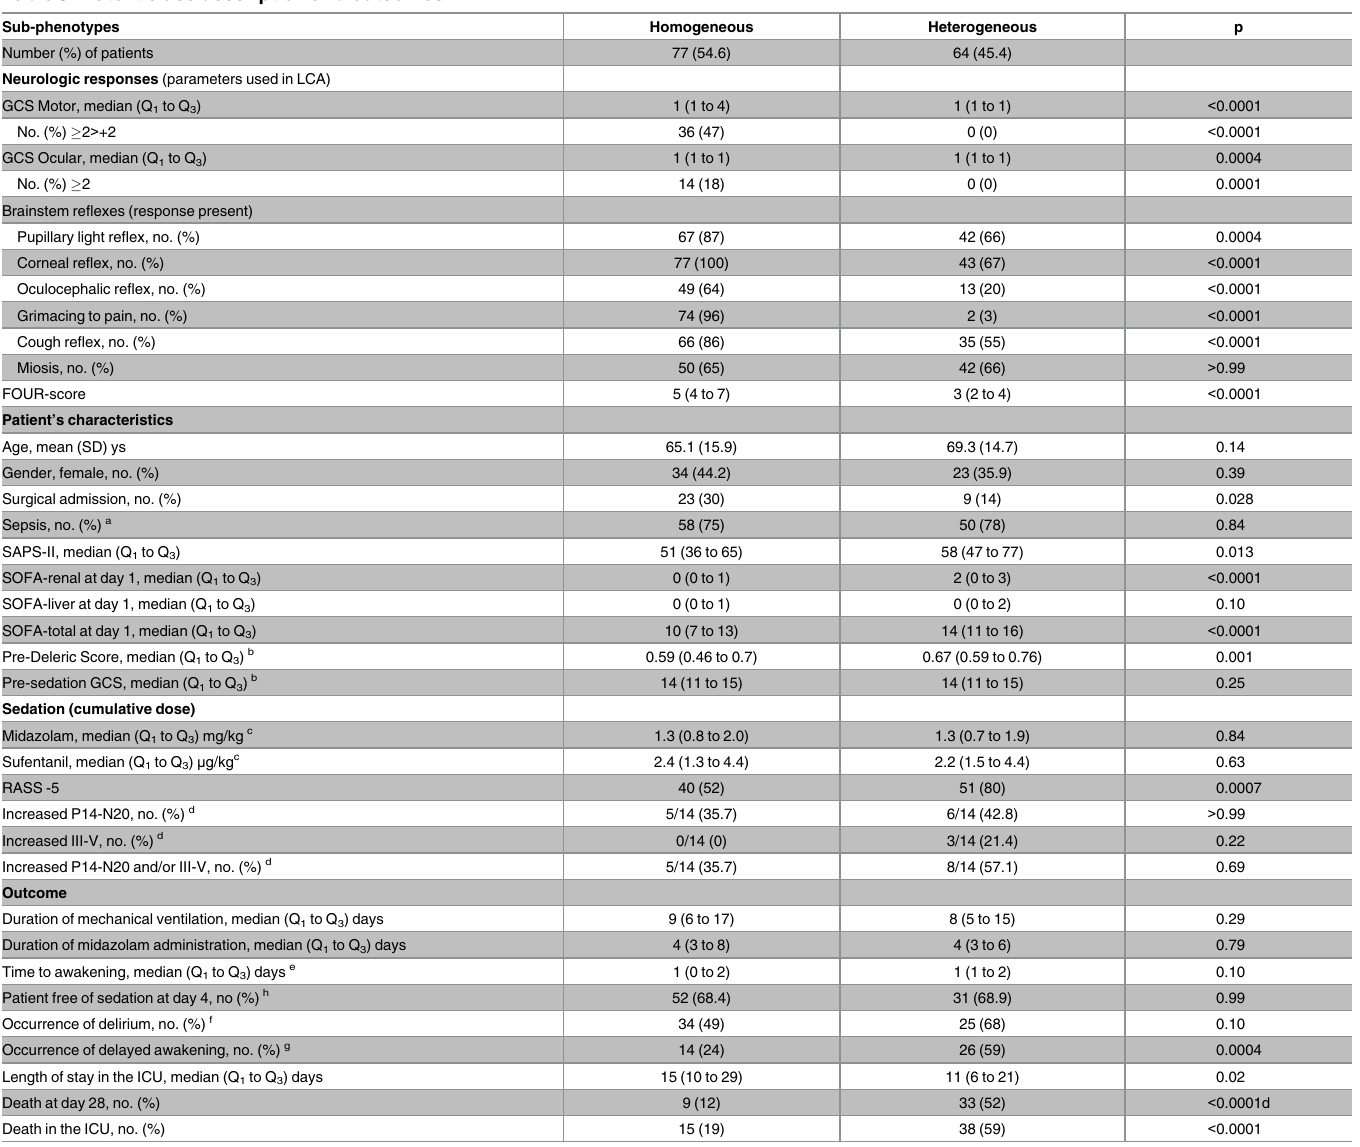
Table 3. Latent class description and